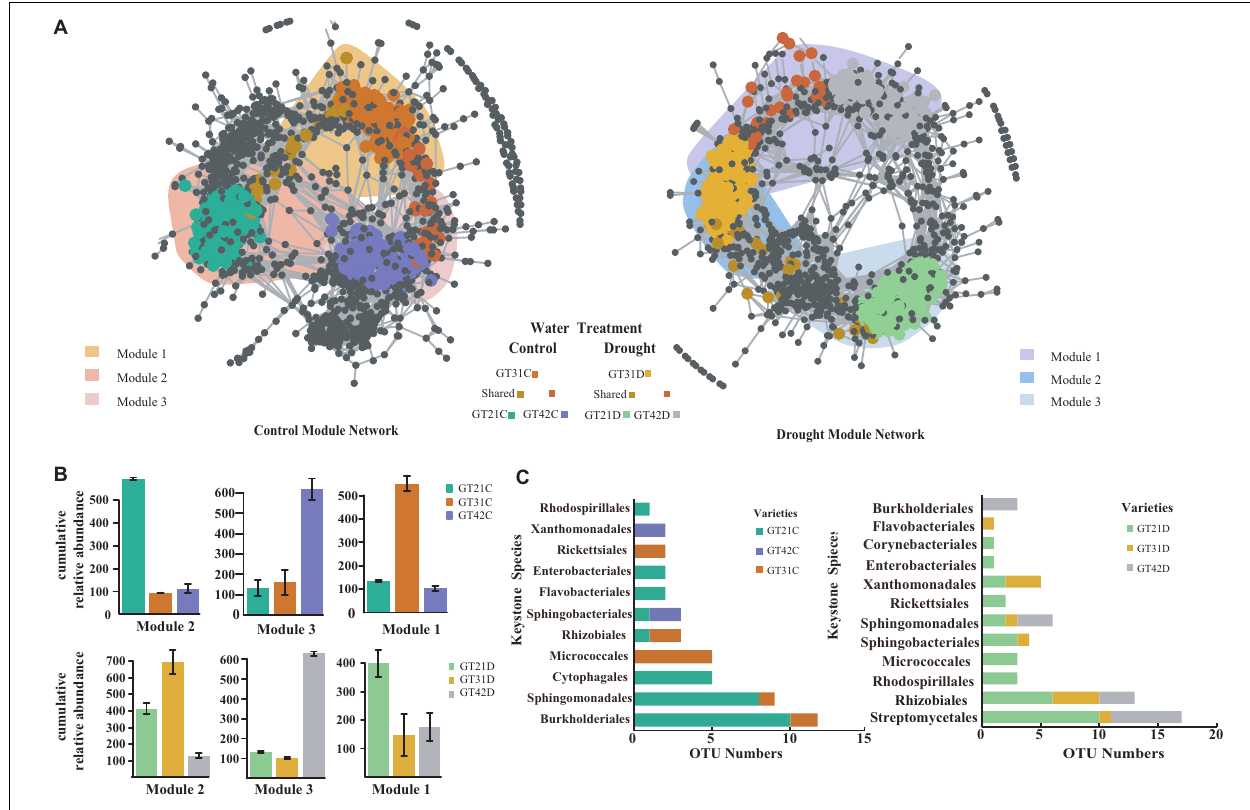
FIGURE 4 | Co-occurrence pattern of sugarcane sensitive OTUs. (A) Co-occurrence network showed the connectivity between the core rhizosphere flora OTUs of each sugarcane variety under water and drought treatment ( ρ > 0.7, P < 0.001; Indicated with gray lines). Gray nodes represent OTUs that are insensitive to variety differences; areas with different colors represent the aggregation modules of dominant rhizosphere flora of different varieties; nodes with different colors correspond to the key dominant flora of different varieties. The lines between the nodes represent the correlation between the connected OTU. (B) The cumulative relative abundance of bacterial OTUs in the aggregation module of different sugarcane varieties under water and drought treatment. (C) Display Keystone Species of different Species according to the number of OTU in the cOTU co-occurrence and abundance of Keystone ( Supplementary Figure 4